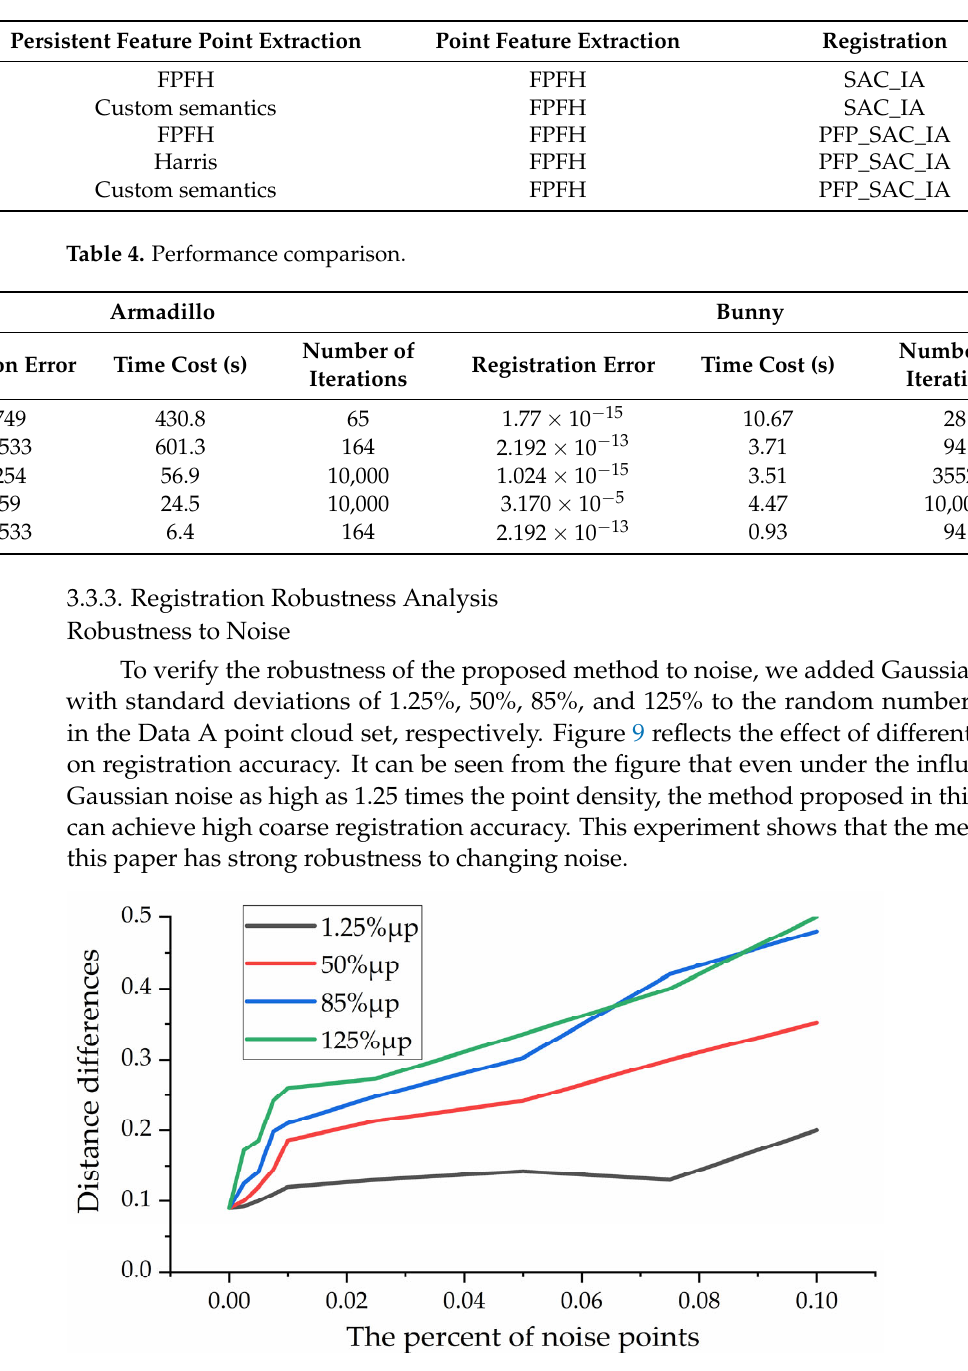
Figure 10. Robustness to varying point density. 3.4. Outdoor Scene Application In order to verify that the method proposed in this paper is also suitable for high ‐ challenging outdoor scenes, the point cloud image collected by the vehicle radar shown in Figure 5a is used for evaluation. Figure 11a is the initial pose map of the point cloud to be registered, and the registration result is shown in Figure 11b.